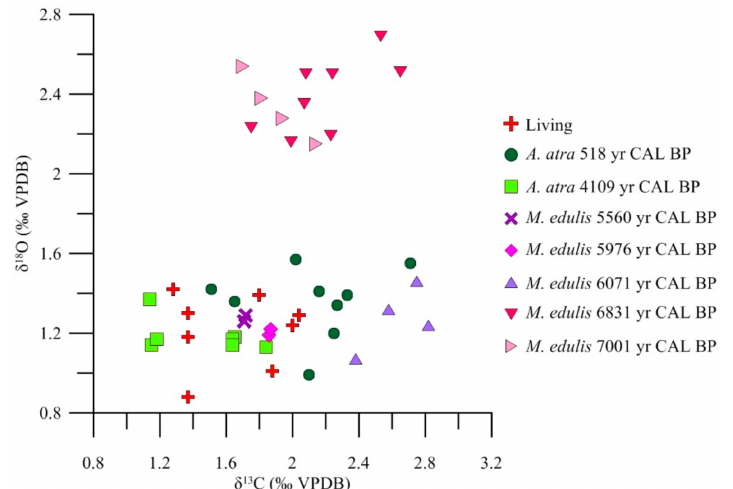
Figure 3. Oxygen and carbon isotope composition for fossil shells. Median calibrated radiocarbon age is reported for each group.